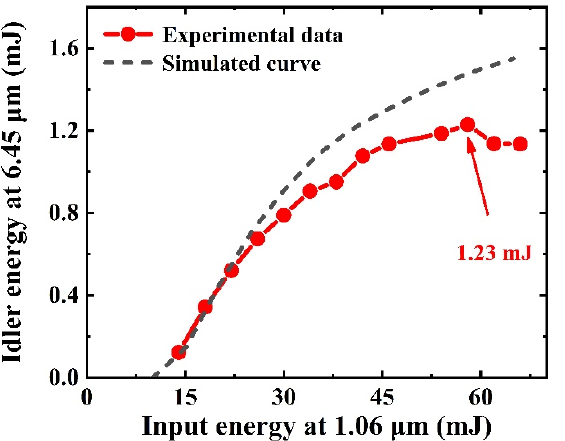
Figure 3. Output idler energy at 6.45 µ m versus input energy in simulation and experiment.